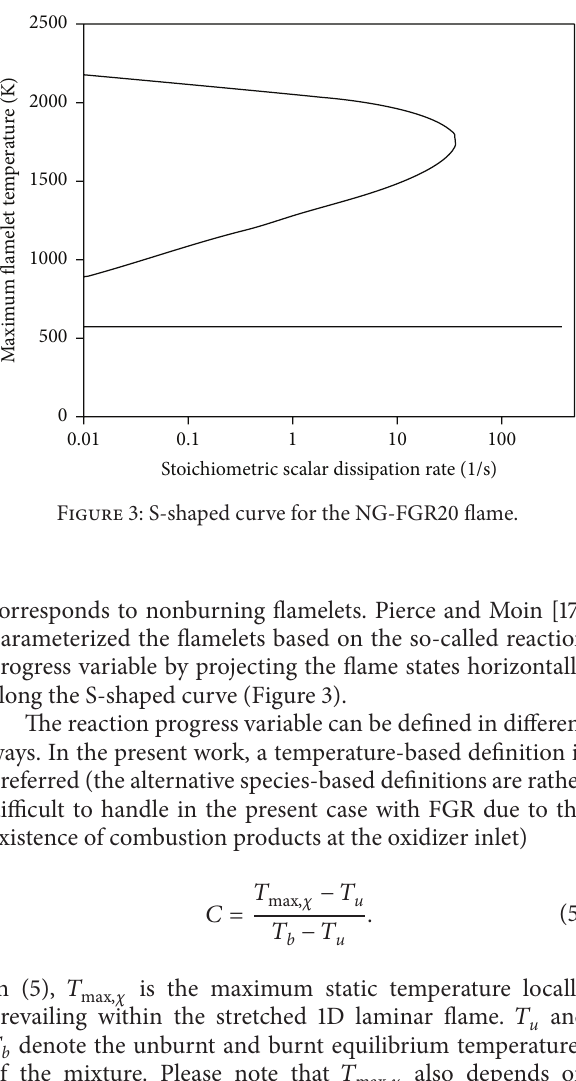
corresponds to nonburning flamelets. Pierce and Moin [17]